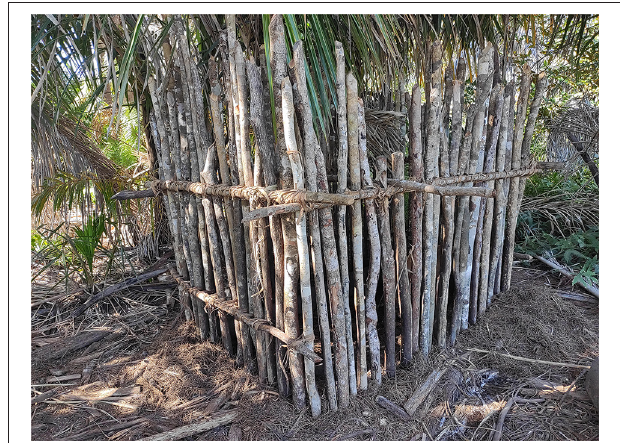
(minimum 1, median 5, maximum 50). Similarly, when kotona were used, a hunter used an average of 1.9 kotona per hunting season (minimum 1, median 2, maximum 5). There were no significant differences between the hunting techniques used per region, except for the spear, which was more commonly used in the SSW region.